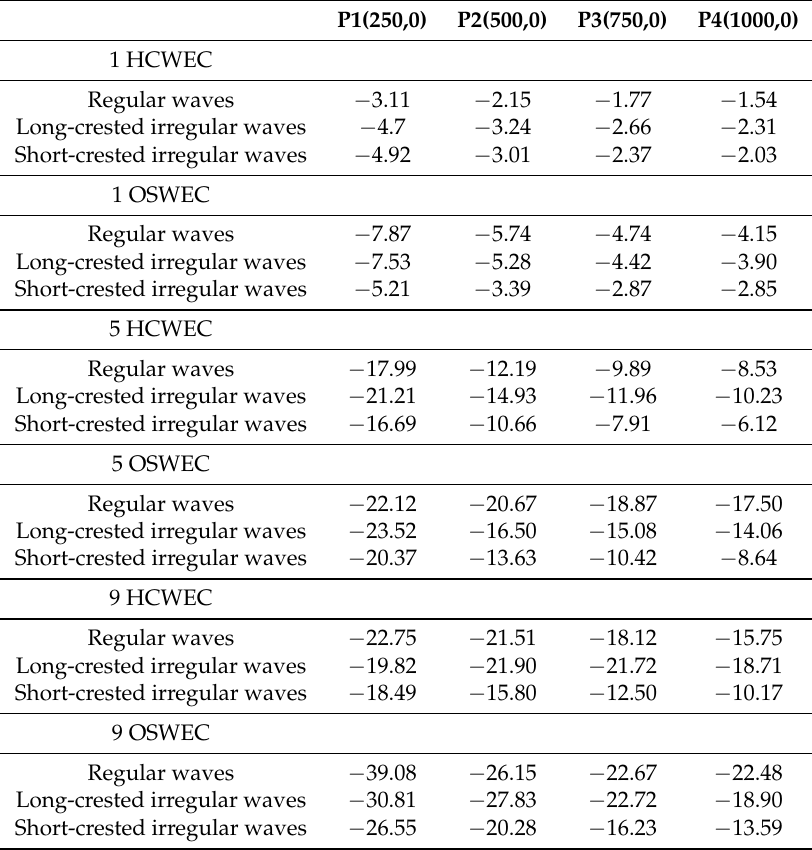
Table 4. K d , dif f (%) at y = 0 m for four different